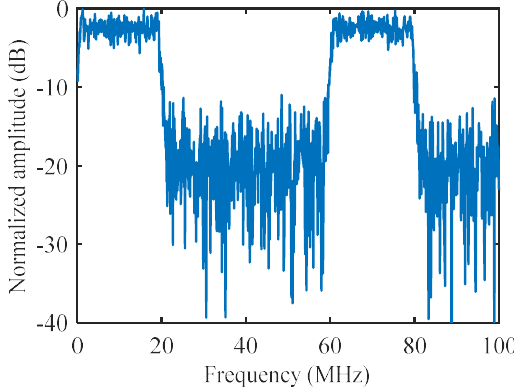
Figure 4. Interference spectrum coding example.